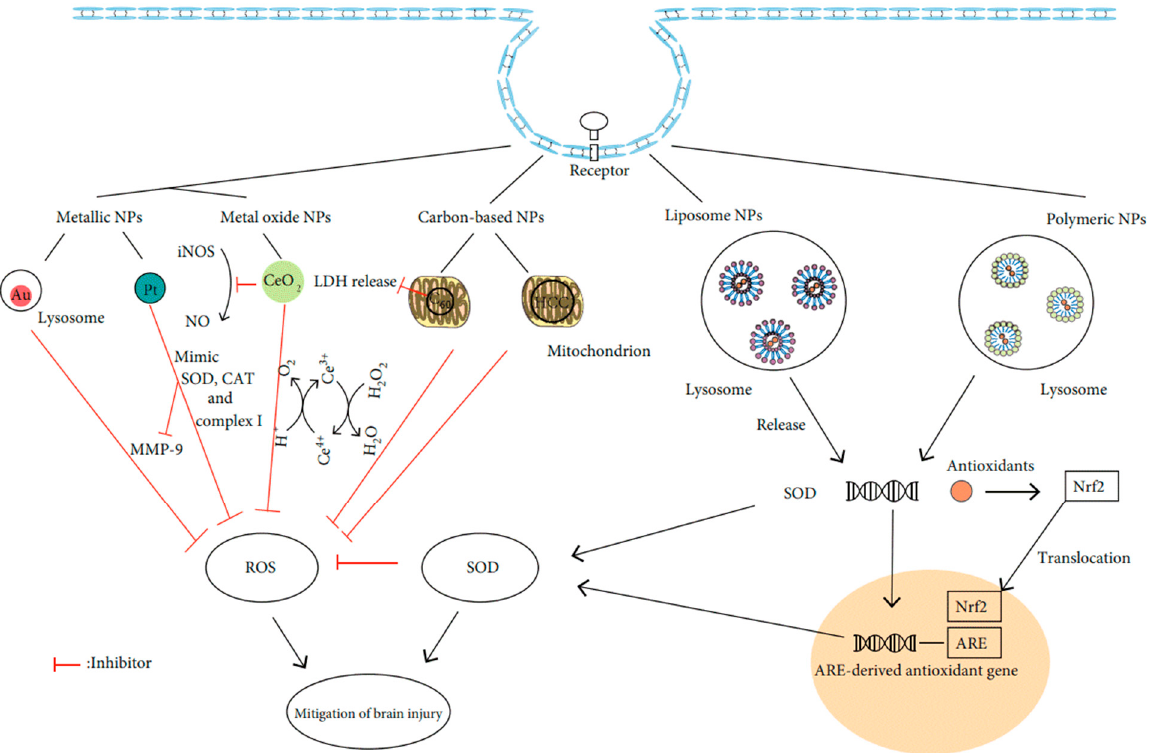
Figure 10. The antioxidant mechanisms of various NP types, after entering a cell by receptor-mediated endocytosis. Metallic, metal oxide and carbon-based NPs exert free radical scavenging properties, for instance by mimicing the activity of superoxide dismutase (SOD), catalase (CAT), and mitochondrial complex I, to decrease the ROS and matrix metalloproteinase-9 (MMP-9) activation. Nanoceria downregulate inducible nitric oxide synthase (iNOS) to decrease NO and ONOO - levels. C60 can be localized in mitochondria to reduce lactate dehydrogenase (LDH) release. Liposome and polymeric nanoparticles can deliver antioxidants, antioxidant enzymes, and genes to minimize the free radicals. Most antioxidants activate nuclear factor-erythroid 2-related factor 2 (Nrf2), advance Nrf2 translocation to the nucleus, and bind with antioxidant response element (ARE) to promote the expression of ARE-derived antioxidant gene. Reprinted from [27] under the terms of the Creative Commons Attribution License.